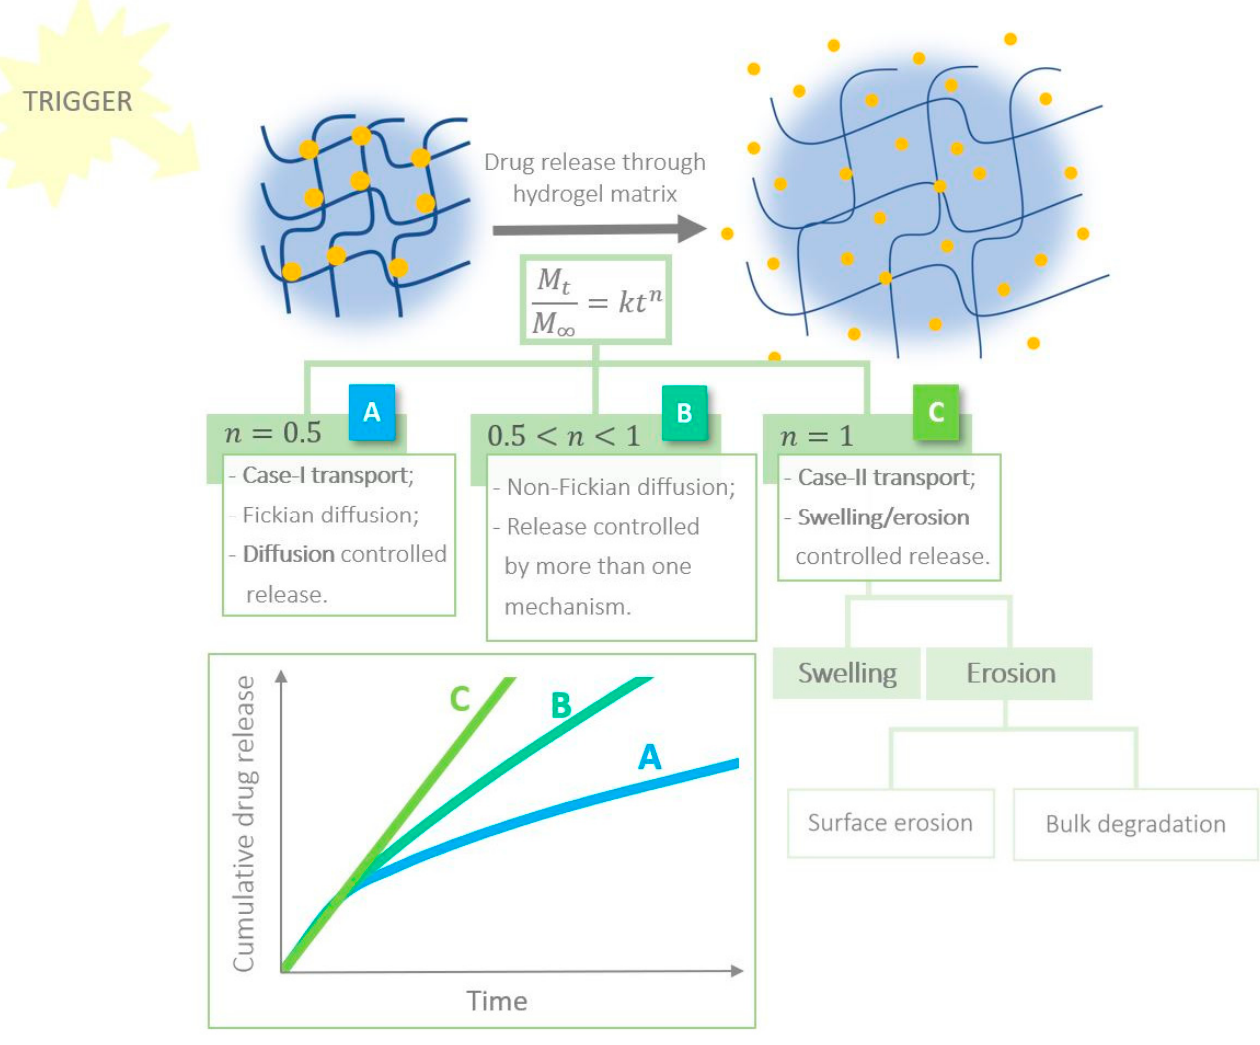
Figure 7. Schematic representation of the different drug release kinetics from a hydrogel matrix and the aspects to consider in case-II transport.